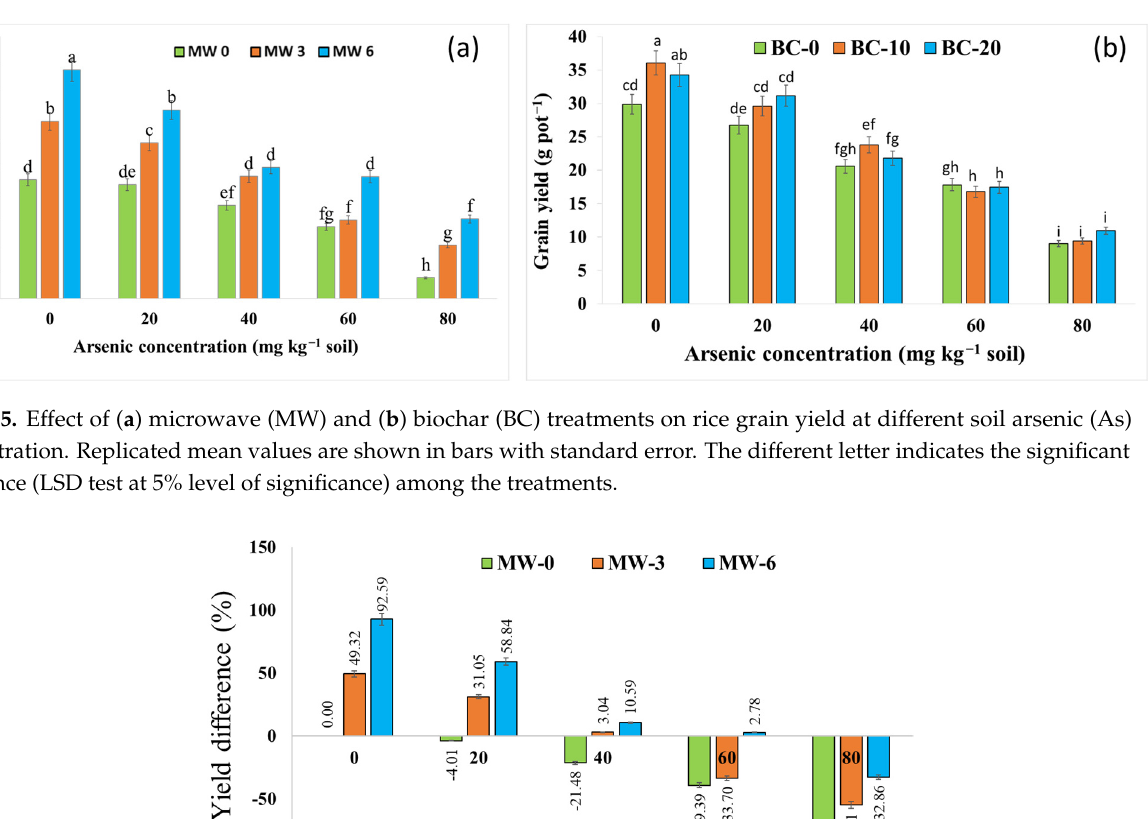
Figure 4. Effect of soil arsenic (As) on spikelet sterility in response to ( a ) microwave (MW) and ( b ) biochar treatments. Replicated mean values are shown in the boxplot. The different letter indicates the significant difference (LSD test at 5% level of significance) among the treatments.